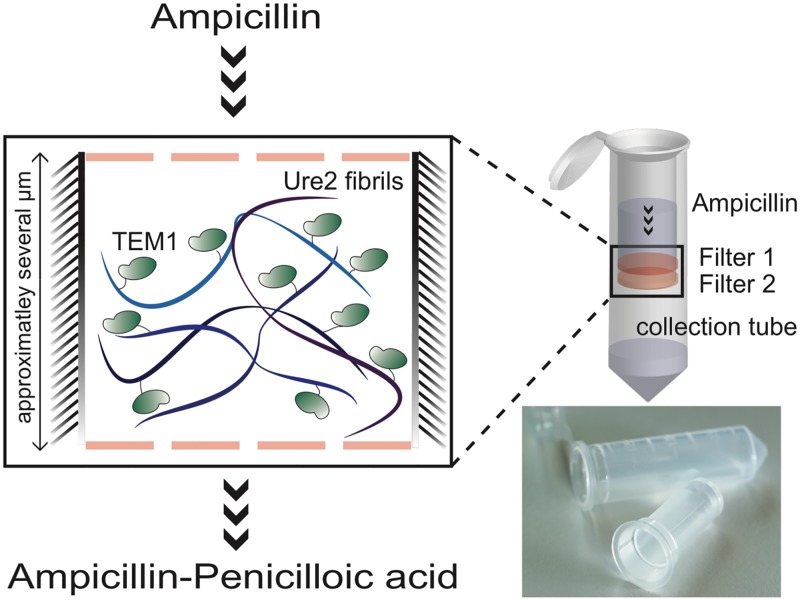
Illustration of the antibiotic degrading flow reactor.Approximately 90–100 μg of TEM1-Ure2(1–80):Ure2(1–80) co-fibrils with a selection of molar ratios in the range of 3x10-3:1 to 30x10-3:1 were trapped on the filter of a spin cup and covered with a second filter. A solution containing ampicillin was loaded onto the spin cup and the setup was centrifuged at 500–3,500 x g to create a continuous substrate flow-through the fibril layer. Lower right corner: Image of the spin filter and the collection tube.